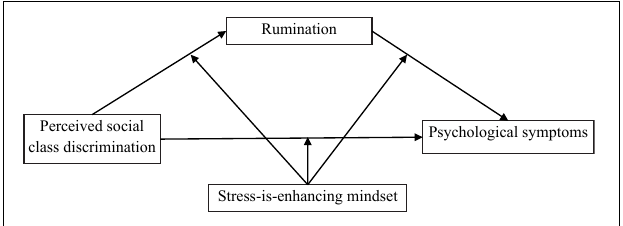
FIGURE 1 | The proposed moderated mediation model. Controlling for age, gender, family income, parents’ education attainment, and subjective socioeconomical